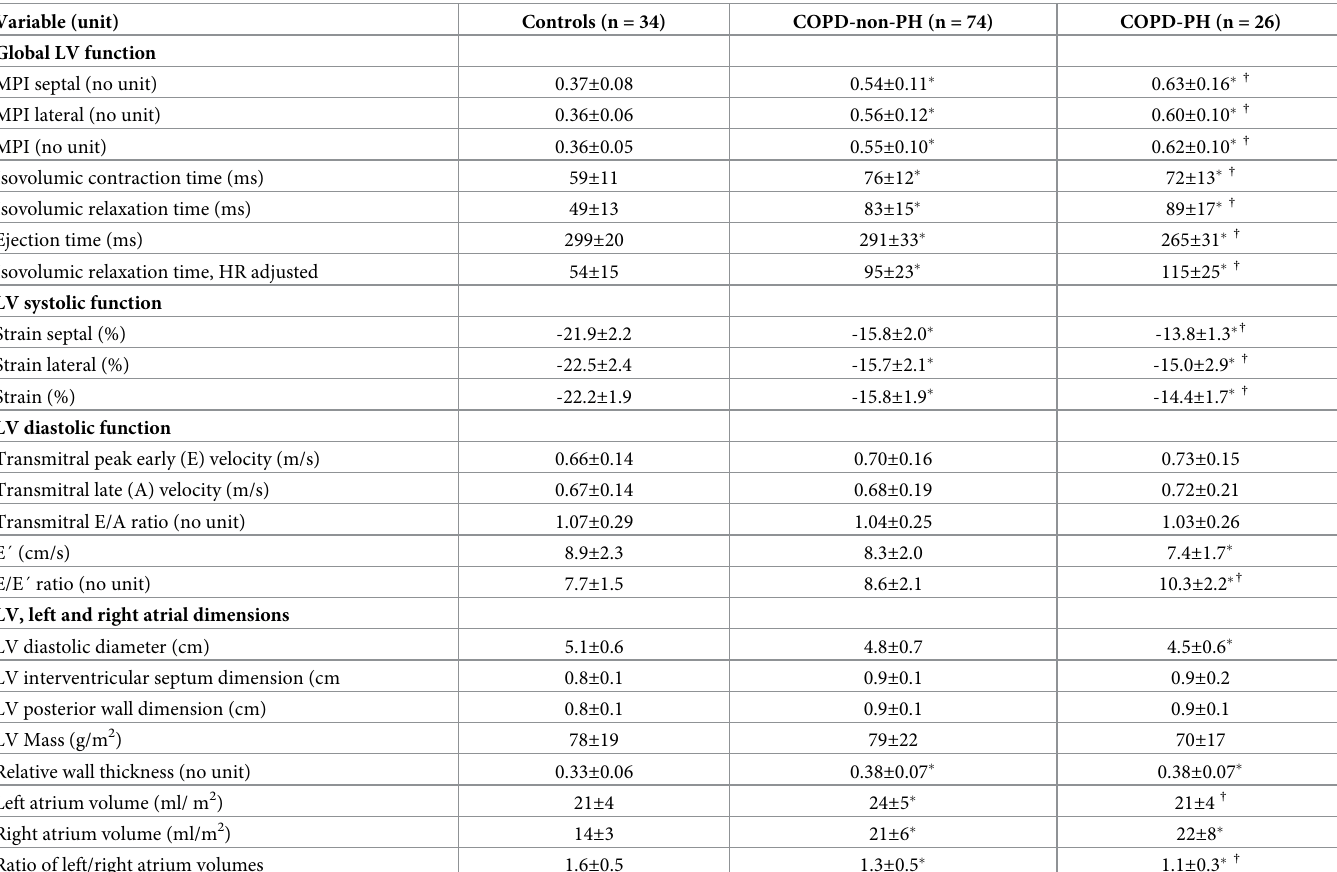
Values are mean ± SD. E´: average of peak early mitral velocities from at the root of septal and lateral mitral leaflet, respectively, HR: heart rate, Isovolumic contraction and relaxation time and ejection time: average of measurements from the root of septal and lateral mitral leaflet, respectively, LV: left ventricular, MPI septal and MPI lateral: myocardial performance index measured at the root of septal and lateral mitral leaflet, respectively, MPI: average of MPI septal and lateral, strain septal and lateral: strain measured at basal third of LV septal and lateral wall, respectively, strain: average of strain septal and lateral, TDI: Tissue Doppler imaging. � Significantly different from controls, † significantly different from